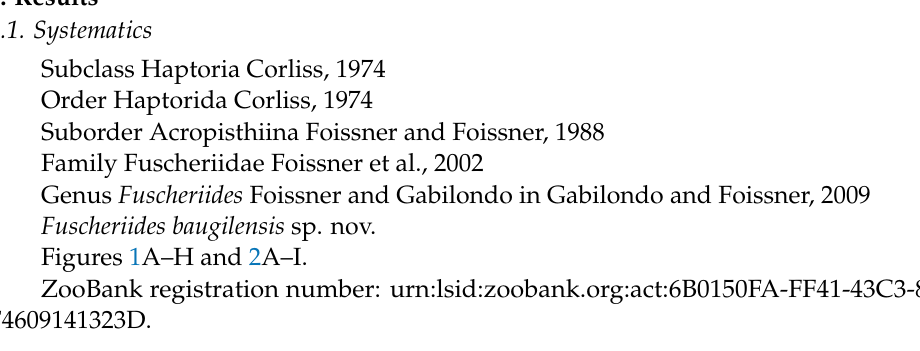
FigTree v1.4.4 (http://tree.bio.ed.ac.uk/software/figtree/). Pairwise distances were calcu- lated in Mega 6.06 [25], using the p -distance method.